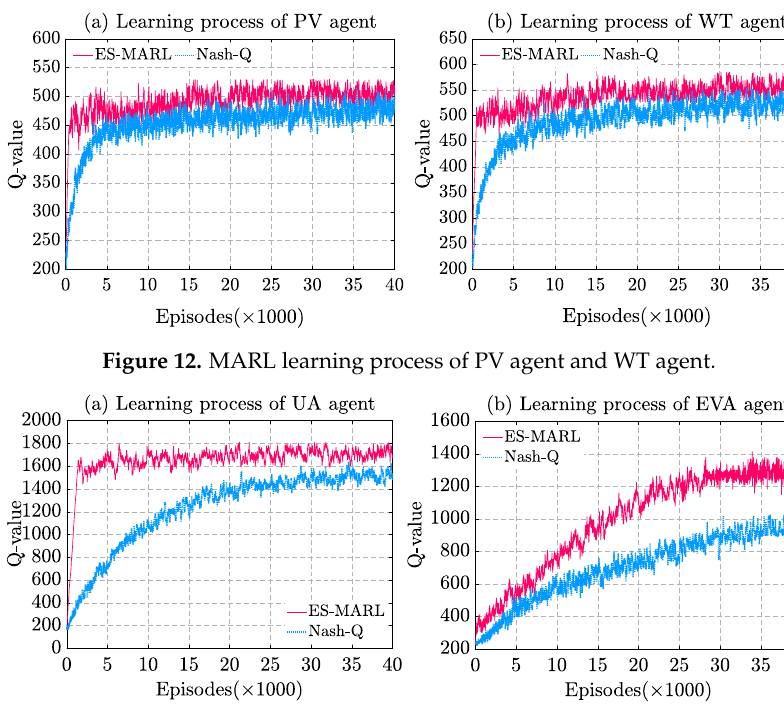
Figure 13. MARL learning process of UA agent and EVA